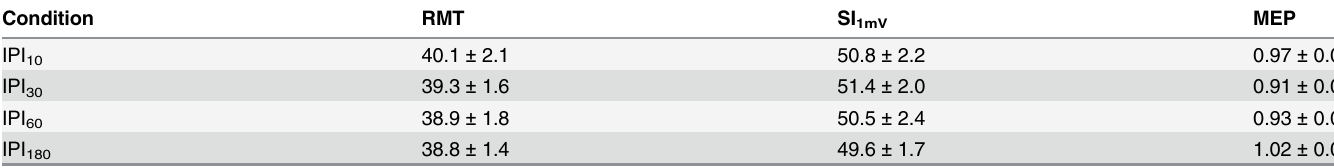
Table 1. Summary of baseline excitability measures in the different IPI conditions.